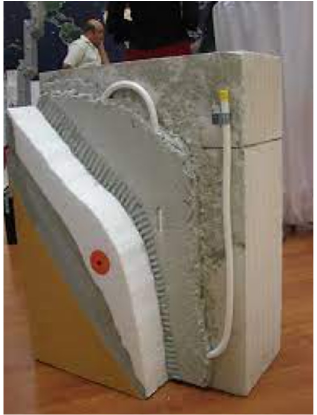
Figure 1. Lost formwork for reinforced concrete building envelope ISOMAX [5].